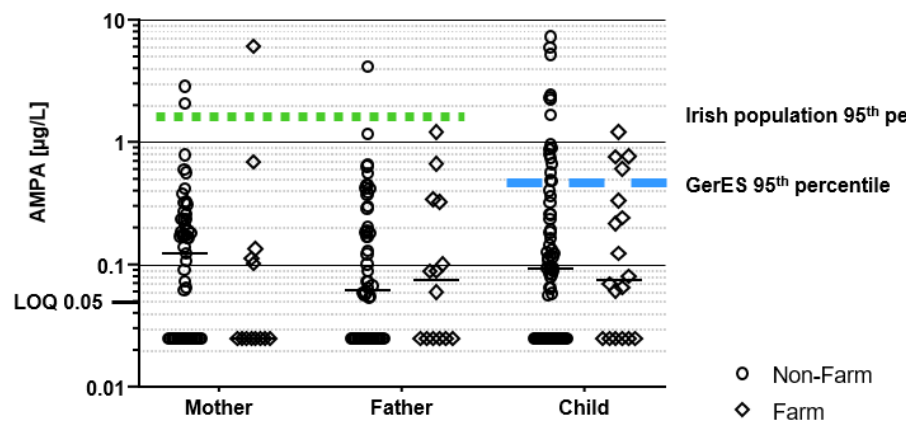
Figure 1. Urinary concentrations of glyphosate by the family member (e.g., mother, father, child) and family type (e.g., farm and non-farm). Comparisons made with the 95th percentile of HBM study of the Irish adult population [57] represented by green dots and the 95th percentile of a Ger- man children population from the GerES study [31], represented by a blue dash.